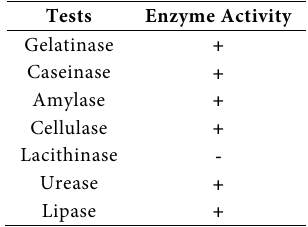
Table 4. Enzyme activity of GRC1 (+ Positive activity, - Negative